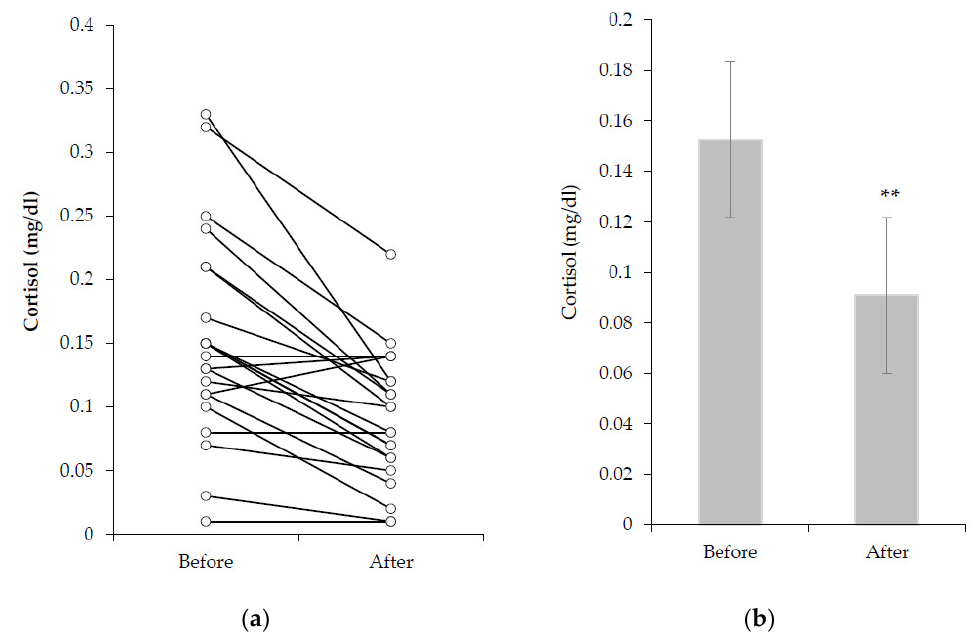
Figure 2. Saliva cortisol concentration before and after training, ( a ): for each swimmer, ( b ): mean values between groups. ** = Statistically significant difference between